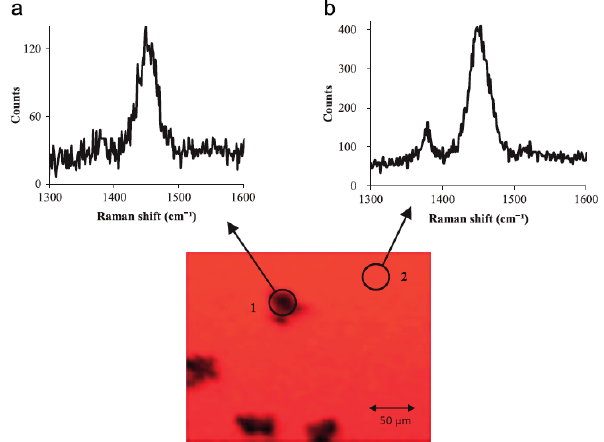
Figure 14. Raman spectra recorded for a thermally annealed thin film (P3HT:PCBM,